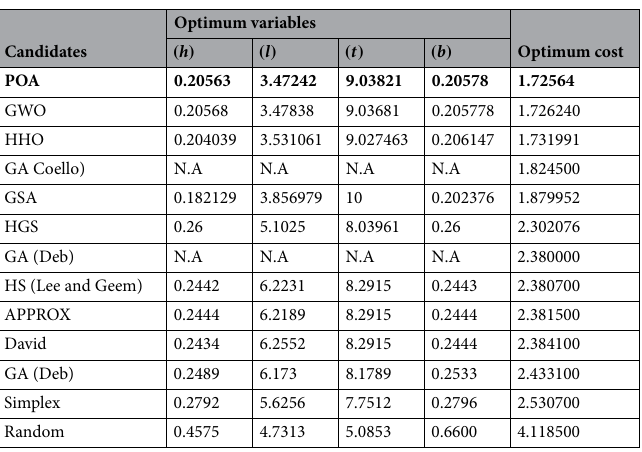
Table 14. Comparison of results for welded beam design problem. Significant values are in bold.